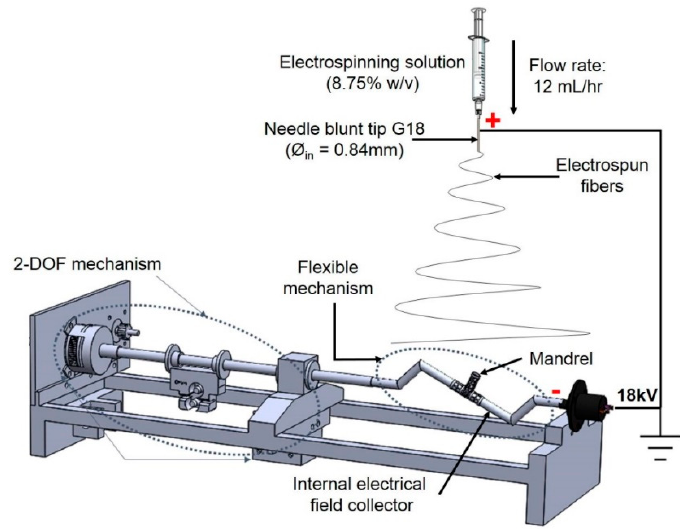
Figure 3. Two degrees of freedom (2-DOF) mechanism used for bifurcated vascular graft membrane.